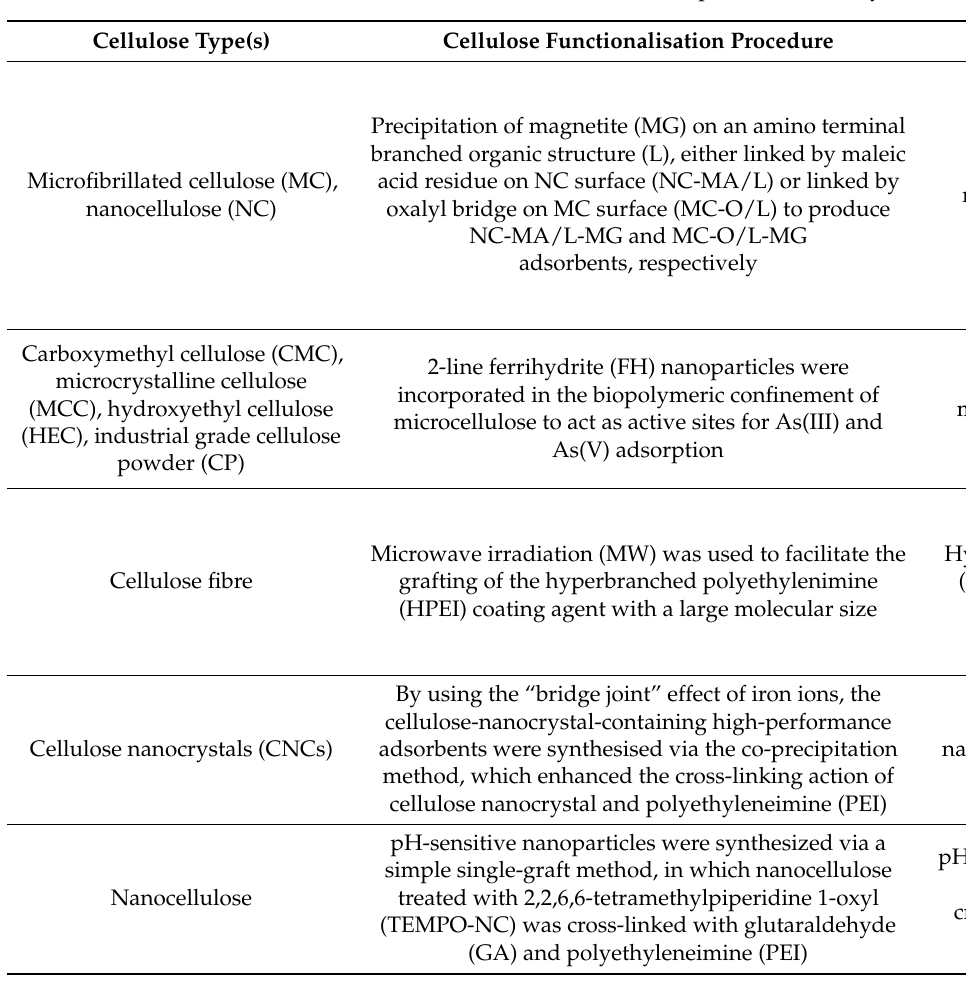
Table 2. Various studies on the adsorption of arsenic by functionalised cellulose